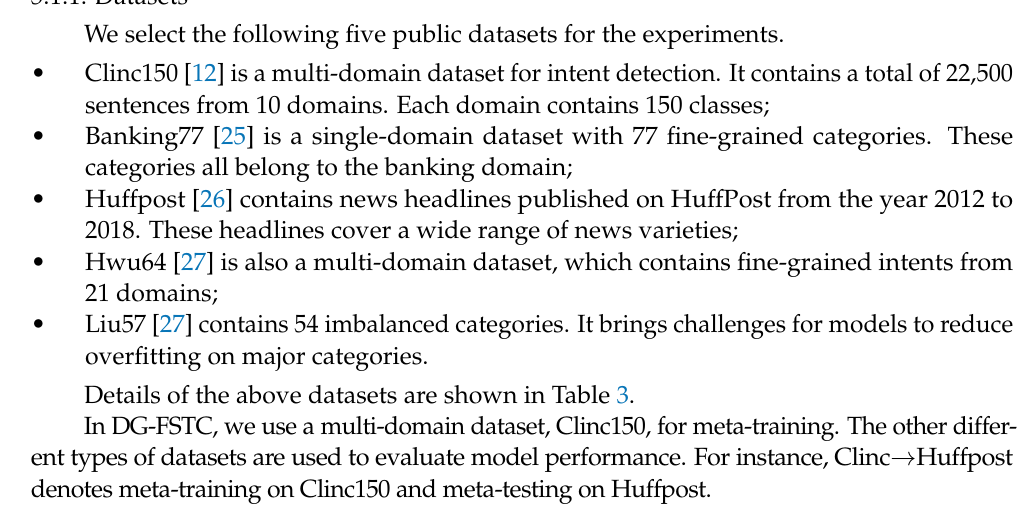
Table 3. Dataset statistics. unk denotes